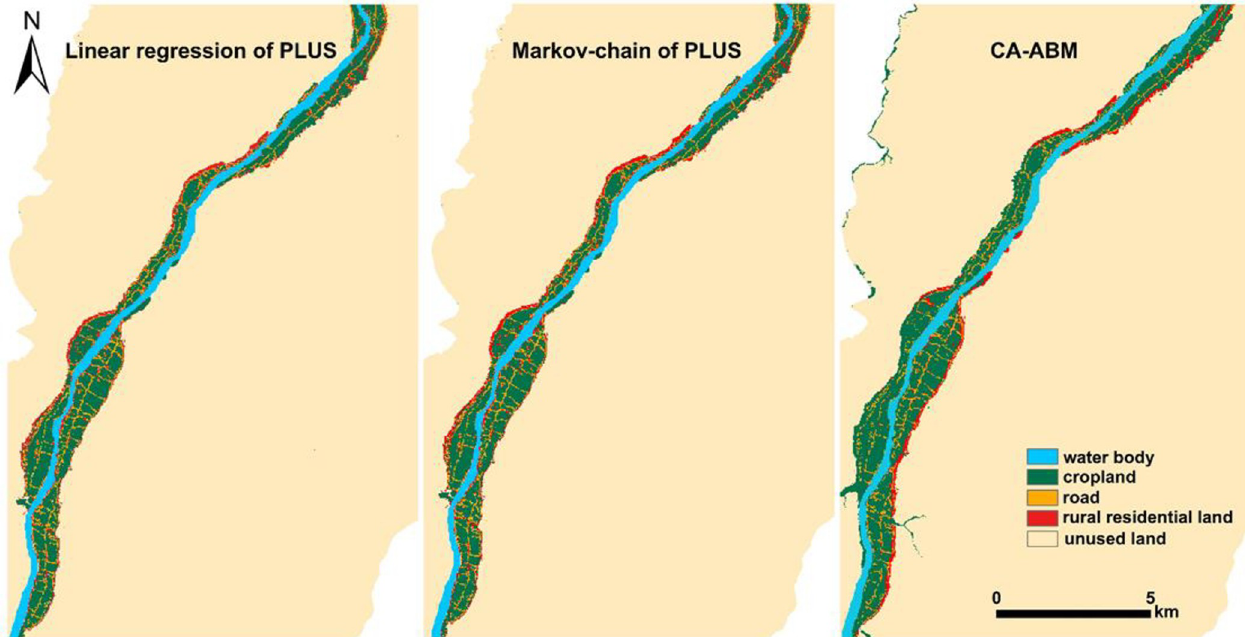
Fig 9. Simulation results of the local spatial distribution of land use in QPT in 2026 obtained by three methods. (Software: ArcMap 10.2.0, http://www. esri.com).